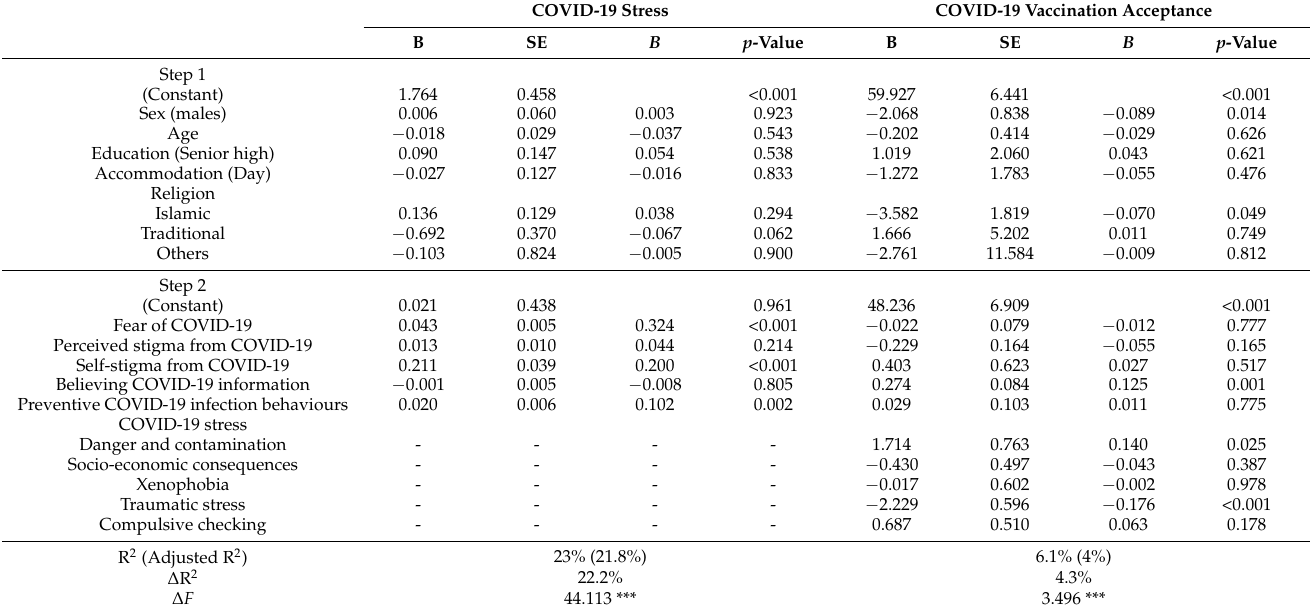
Table 4. Factors predicting adolescents’ COVID-19 stress and COVID-19 vaccination acceptance. COVID-19 Stress COVID-19 Vaccination